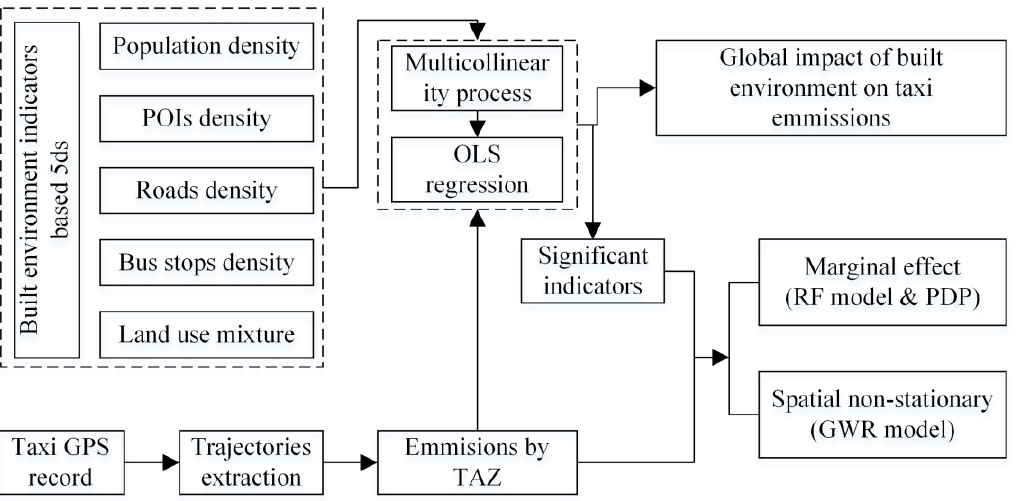
Table 1. Data Source.